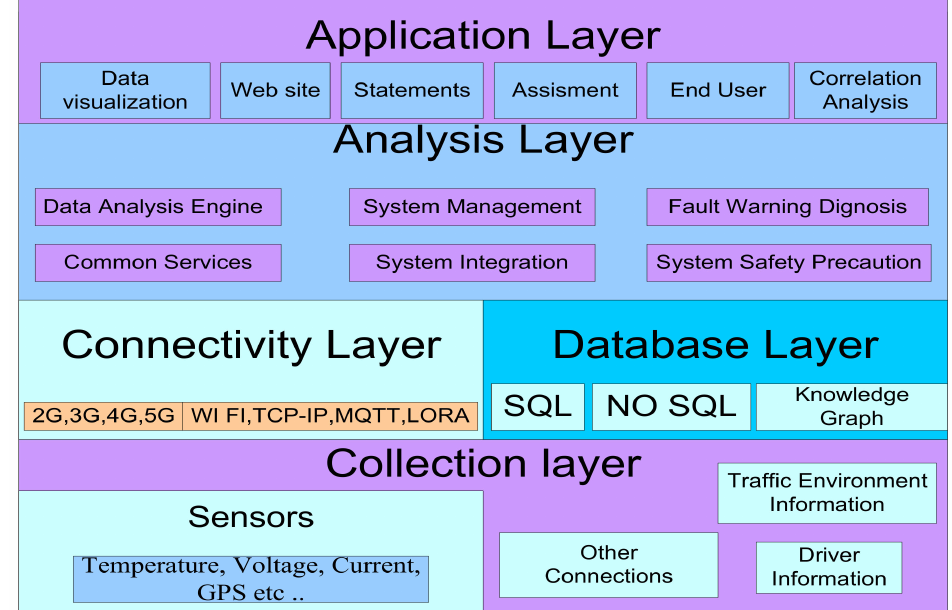
Figure 8. The architecture of a cloud-connected battery-management system.